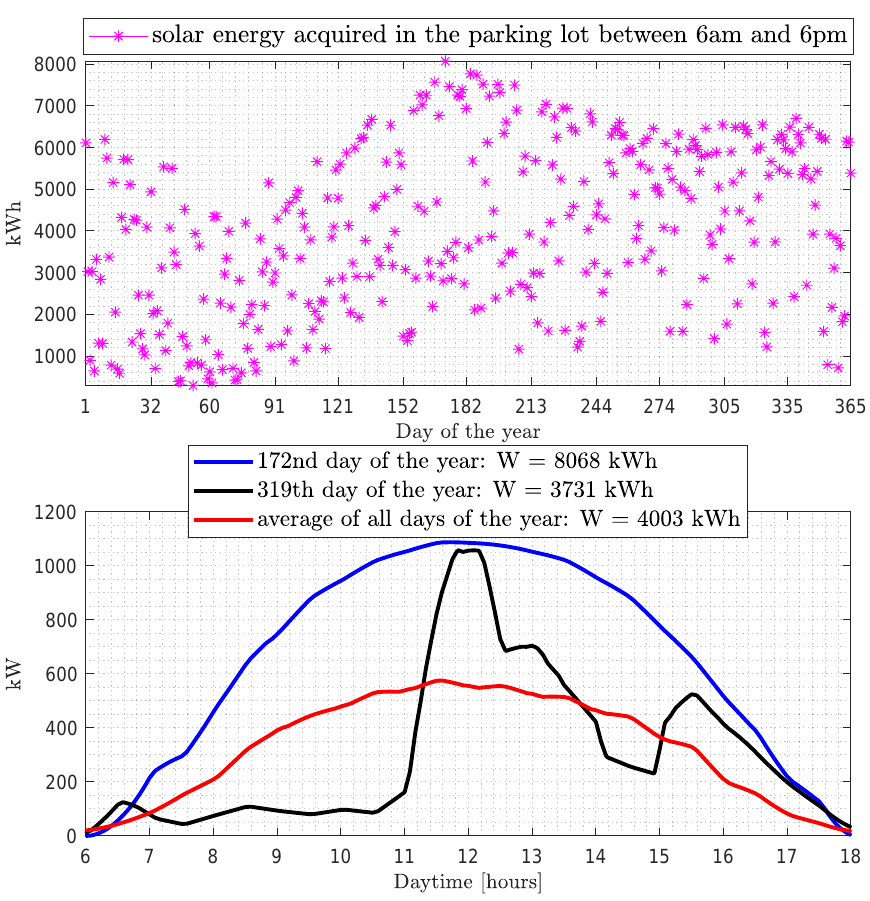
Figure 2. Solar energy production in the parking lot with 100 PV panels in Montreal